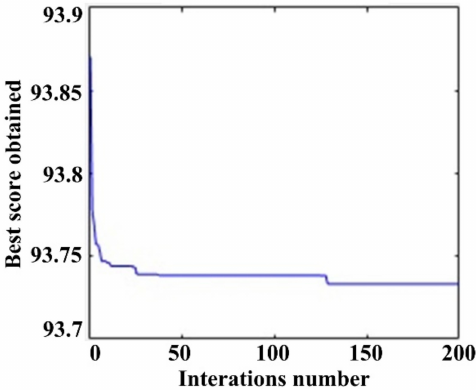
Figure 20. Evolution of the performance of the GWO-type algorithm.